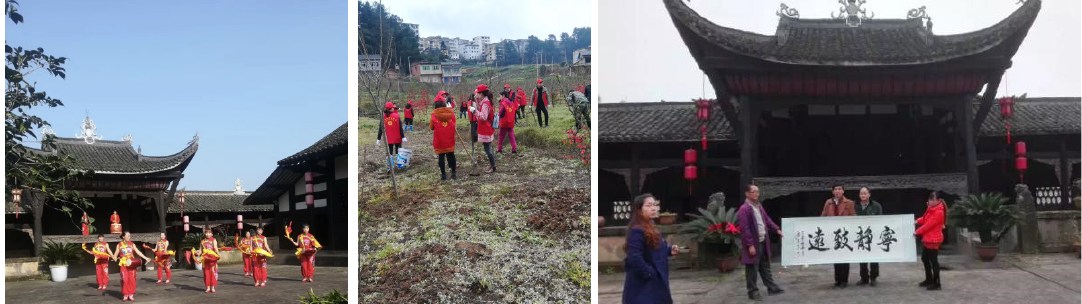
Figure 10. Folklore activities and farming experience activities in the Chen manors (source: Taken by the author).